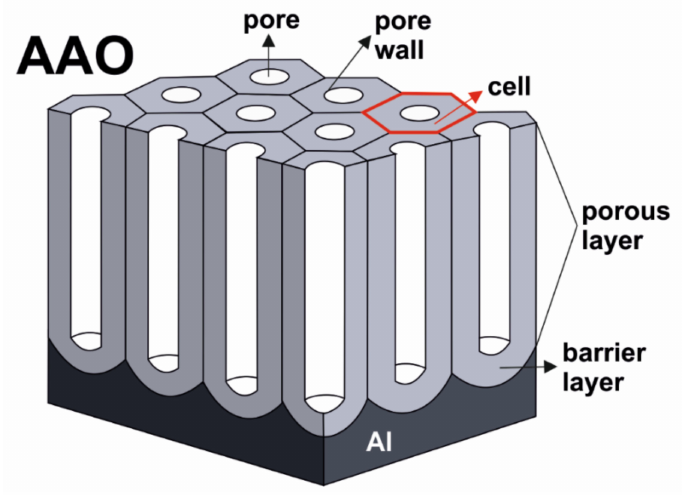
Figure 3. Schematic morphology of porous anodic aluminum oxide (AAO) on Al foil. Reproduced with permission from Ref. [64]. Copyright 2020 Elsevier Ltd.